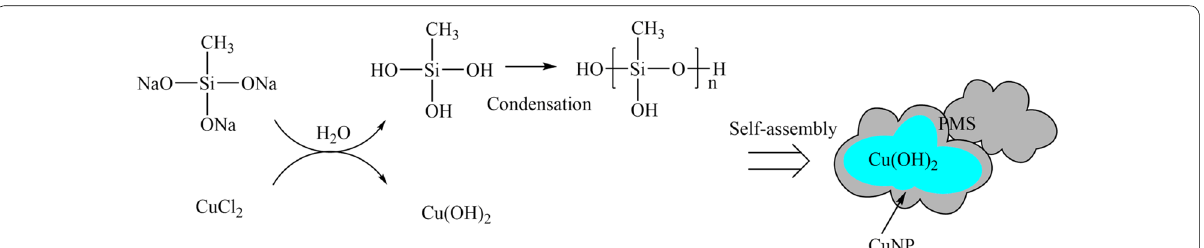
Fig. 1 Schematic diagram of PMS/CuNP